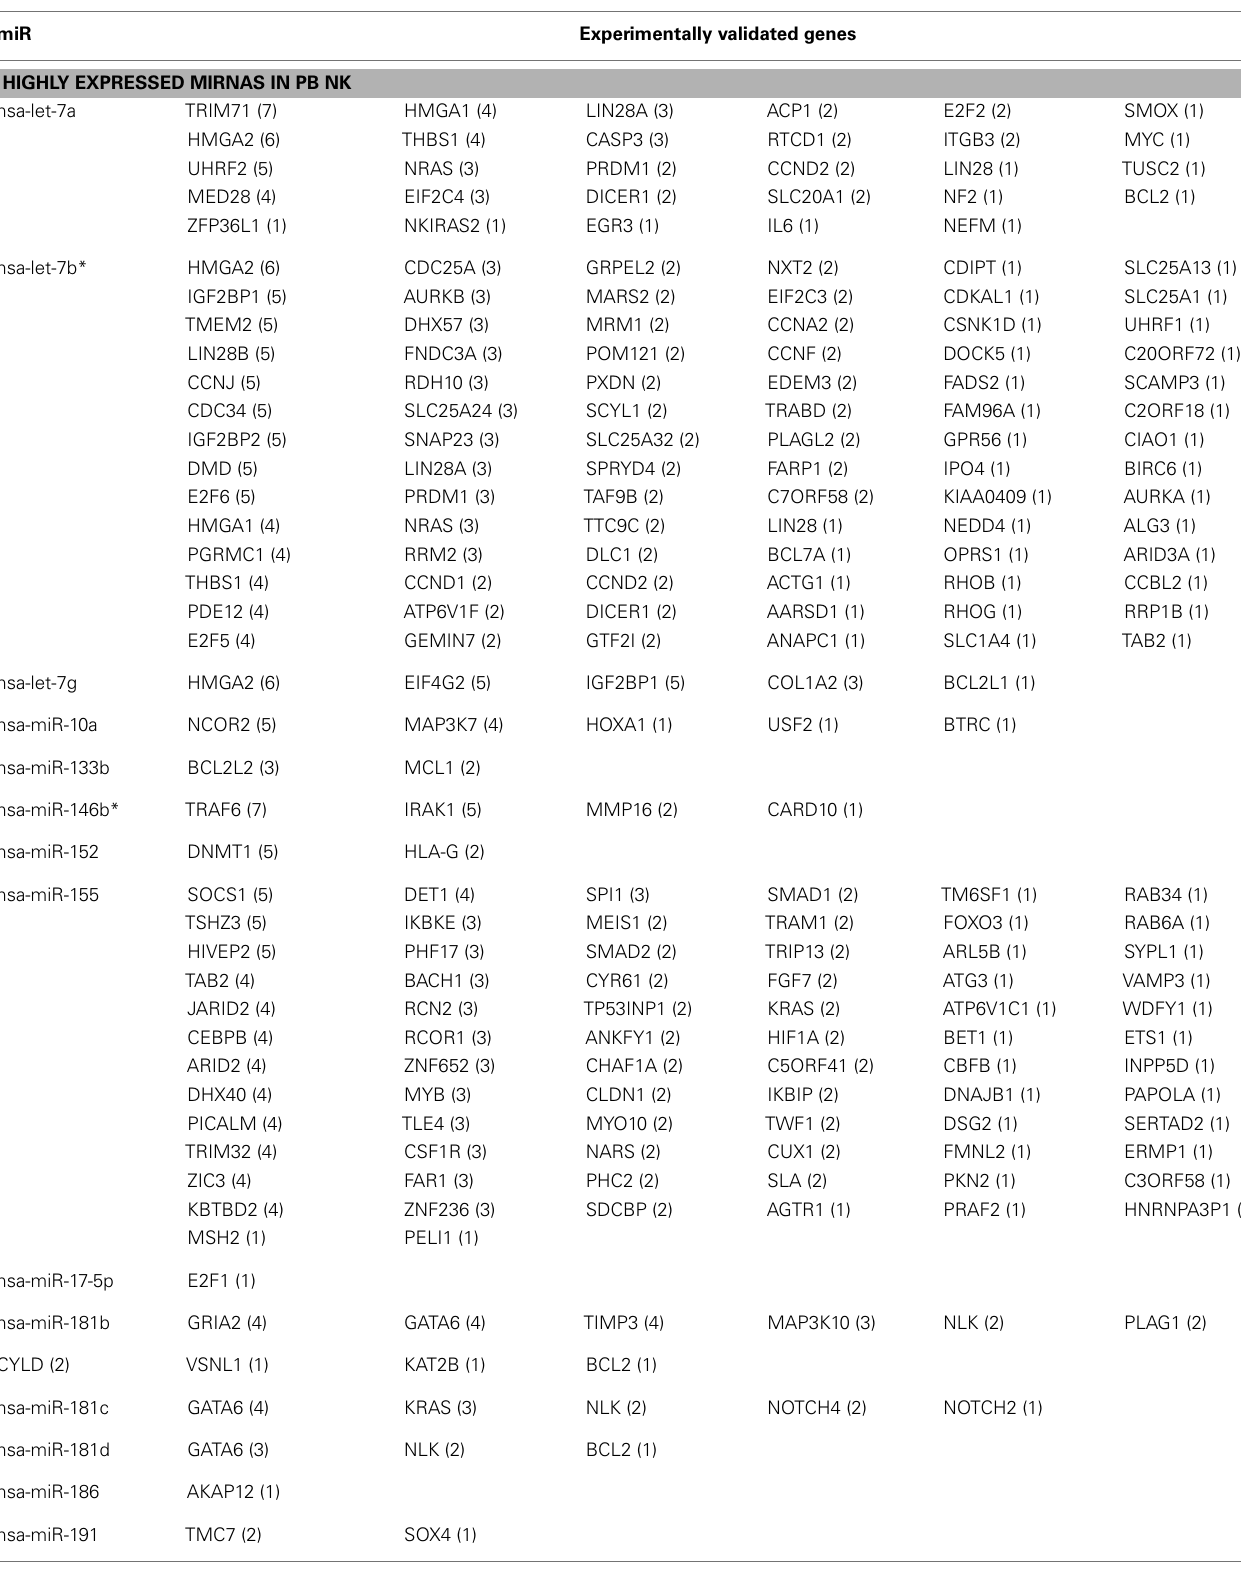
Table 5 | Differentially regulated miRs and their validated target genes in pNK, compared to PB NK.